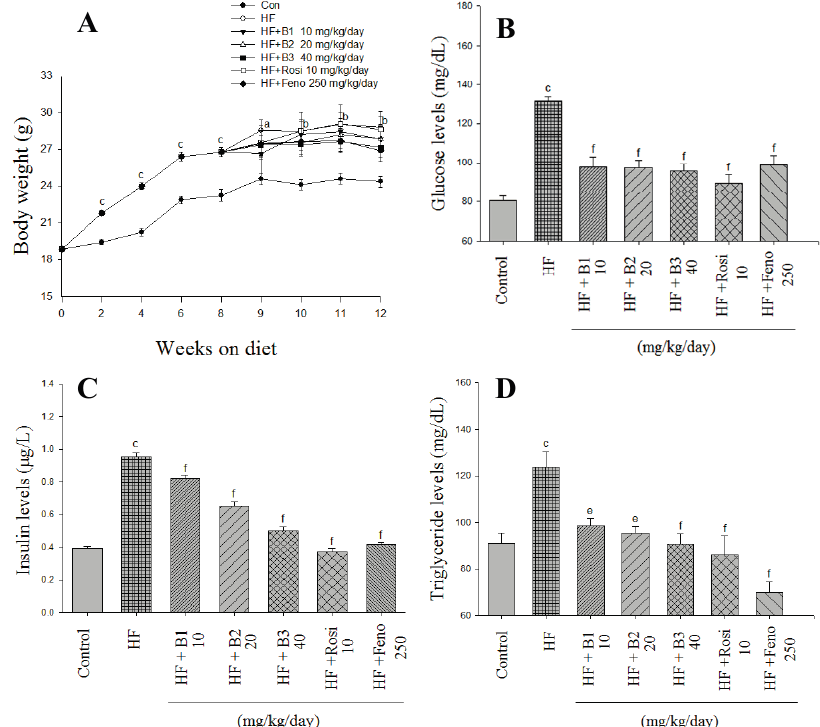
Figure 2. Effects of ( − )-epicatechin-3- O - β - D -allopyranoside (BB) on ( A ) body weight; ( B ) blood glucose levels; ( C ) insulin levels; and ( D ) triglyceride levels at week 12. Mice were fed with a 45% high-fat diet (HF; high-fat diet control) or low-fat diet (CON)